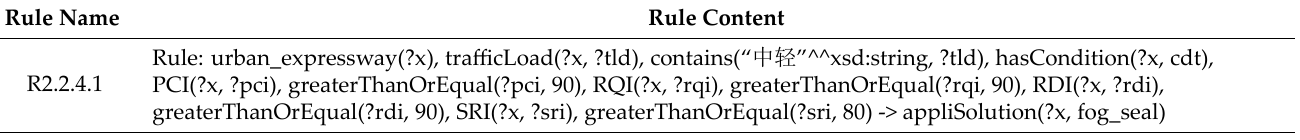
Table A3. Renewal rules for expressways with aging asphalt and moderate/mild traffic